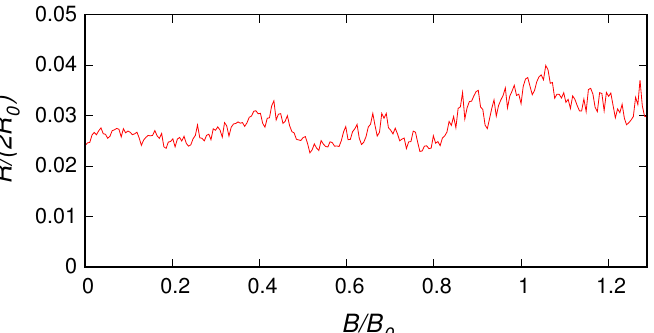
Figure 2. Half of the two-probe resistance (normalized with respect to the resistance quantum R 0 = h / ( 2 e 2 ) ) achieved with our envelope-function-based code for a nanopatterned armchair ribbon with the same size as that studied in reference [52], reported as a function of the orthogonal magnetic field (normalized with respect to B 0 = 97 T, the value corresponding to the primary commensurability